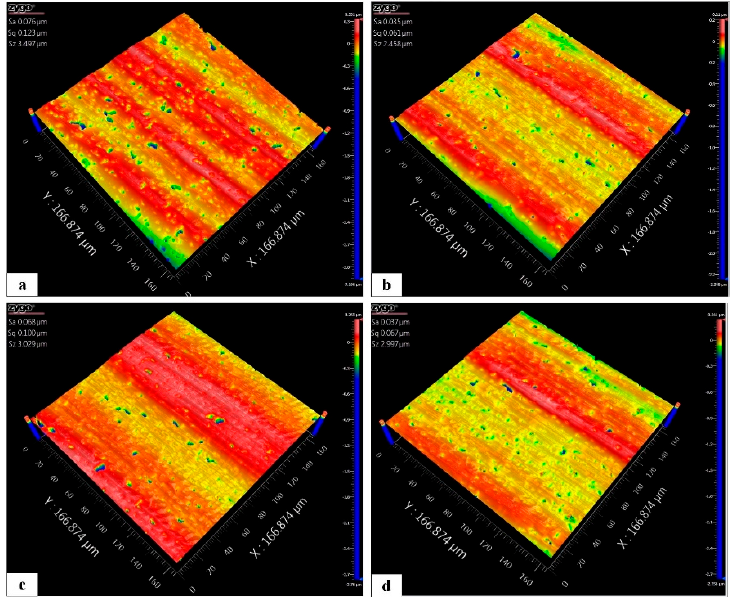
Figure 20. Workpiece surface morphology: ( a ) nonvibration polishing (workpiece 1), ( b ) vibration polishing (workpiece 2) ( c ) small-rotational-angle polishing (workpiece 3) and ( d ) large-rotational-angle polishing (workpiece 4).